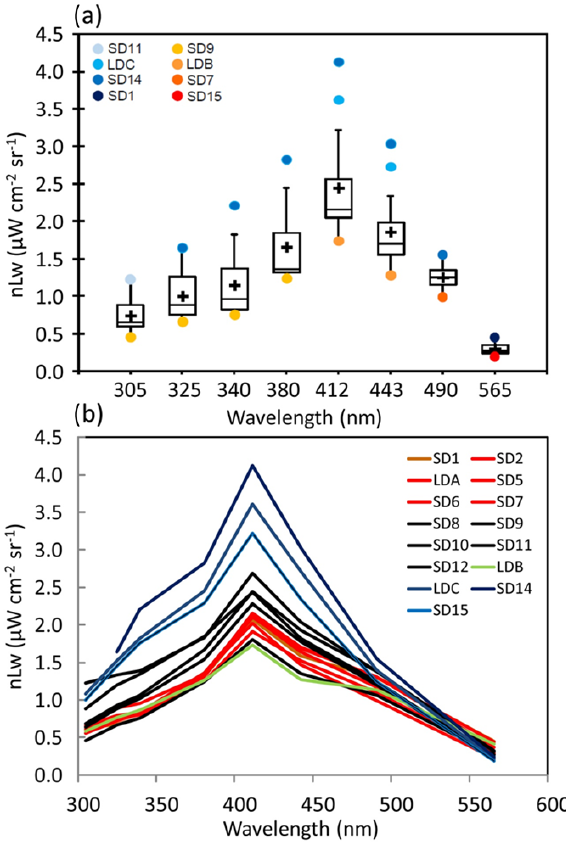
Figure 2. OUTPACE AOPs in the western tropical South Pacific. (a) Box-and-whisker plots for the distribution of nL w (λ) in the UV (305, 325, 340 and 380nm) and visible (412, 443, 490 and 565nm) spectral domains determined between 0 and 30m at stations in the Melanesian archipelago (MA, SD1–SD7 and LDA), Fijian archipelago (FI, SD8–SD11) and South Pacific Gyre (SPG, SD13, LDC, SD14, SD15). The outlier stations are indicated in the upper left (see text). (b) nL w (λ) with color code depending on TChl a (in red: high concentrations (0 . 185 < TChl a < 0 . 35mgm − 3 ; SD1 to SD7, Melanesian archipelago), in black: median concentrations (0 . 06 < TChl a < 0 . 1mgm − 3 ; SD8 to SD11 around islands of Fiji), in blue: low concentrations (TChl a < 0 . 11mgm − 3 ; SD14 to SD15 including LDC) with the frontal station LDB in green (Ta- ble